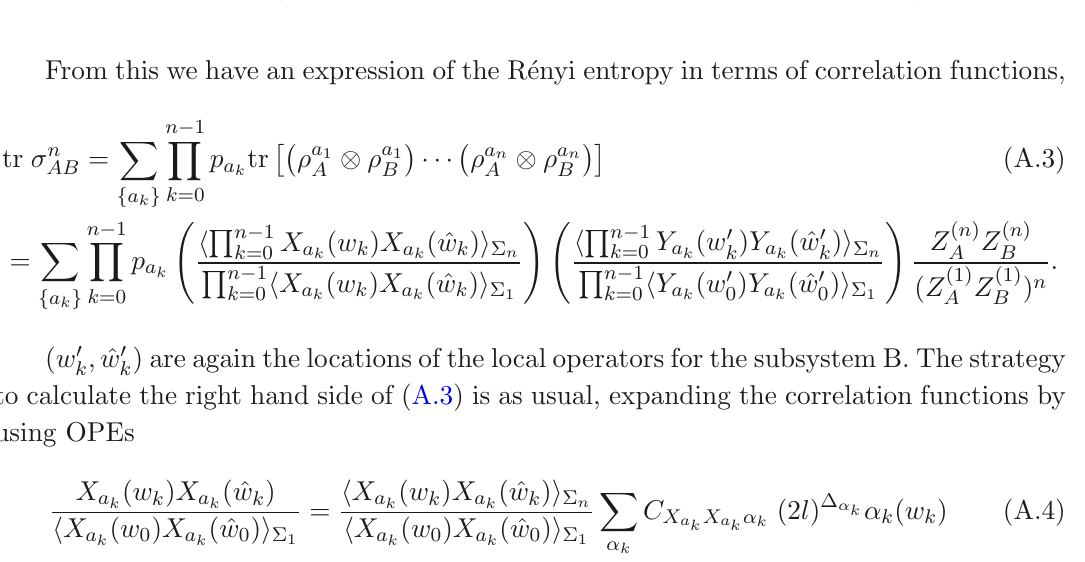
Figure 2 . A graphical representation of the expansion the Renyi